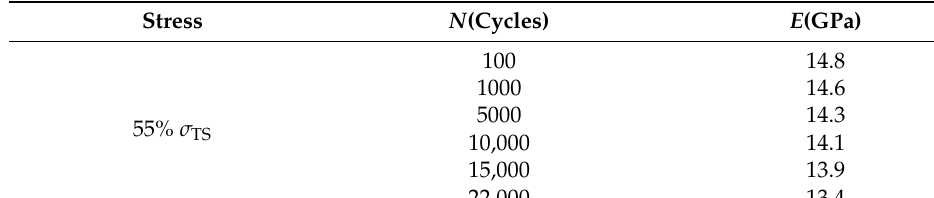
Figure 17. Stress–strain curve change of the elastic modulus.